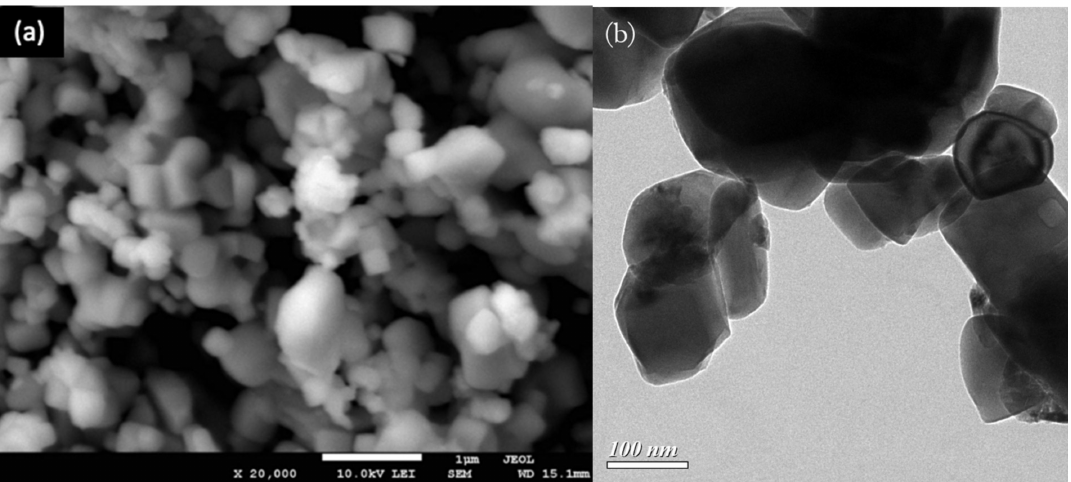
Figure 9. ( a ) SEM of SrTiO 3 :Rh and ( b ) TEM of SrTiO 3 :Rh.